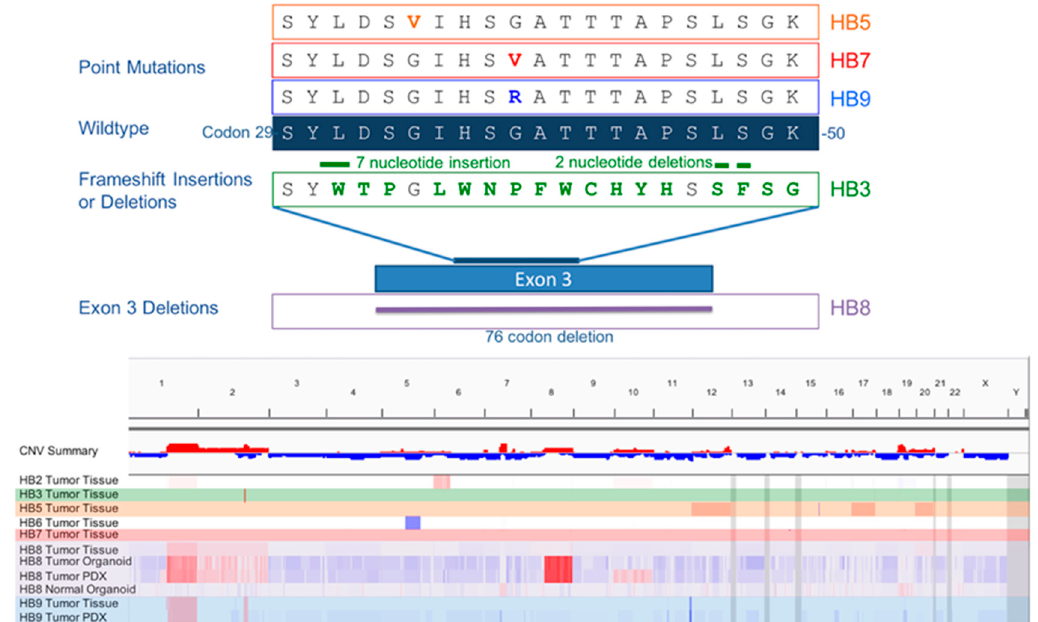
Figure 3. Mutations in exon 3 of CTNNB1 were found in 4 out of 7 tumor samples. Three tumors had a single point mutation. HB8 tumor had a complete deletion of exon 3, while another (HB3) had multiple frameshift insertion / deletions. A copy number variation plot for all tissue and organoid samples demonstrates that tumors reflect known hepatoblastoma copy number variations. These variations are similarly reflected in tumor organoid and PDX samples but not in normal organoid samples.